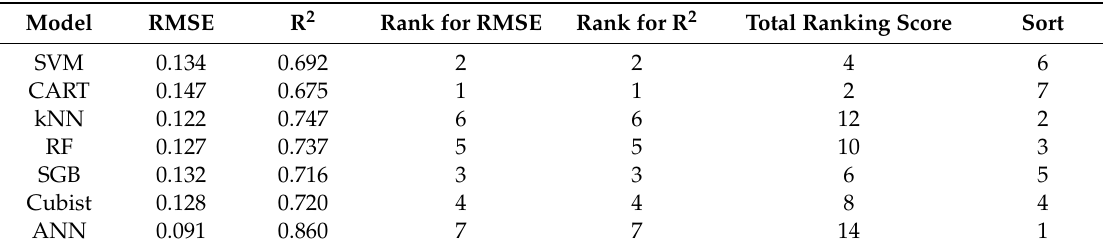
Table 3. Performance of the soft computing techniques for estimating ilmenite content (training dataset).